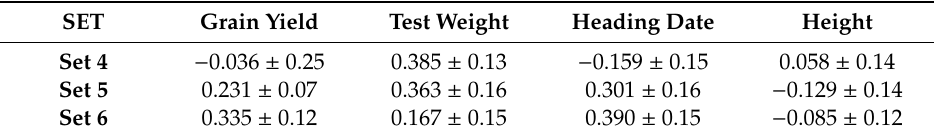
Table 4. Mean prediction accuracy and standard error of the mean for wheat grain yield (t ha − 1 ), test weight (kg hL − 1 ), heading date (days after 1 January) and height (cm). Genomic selection was applied to each family individually. Values of prediction accuracy are the average accuracies among families for each data set.